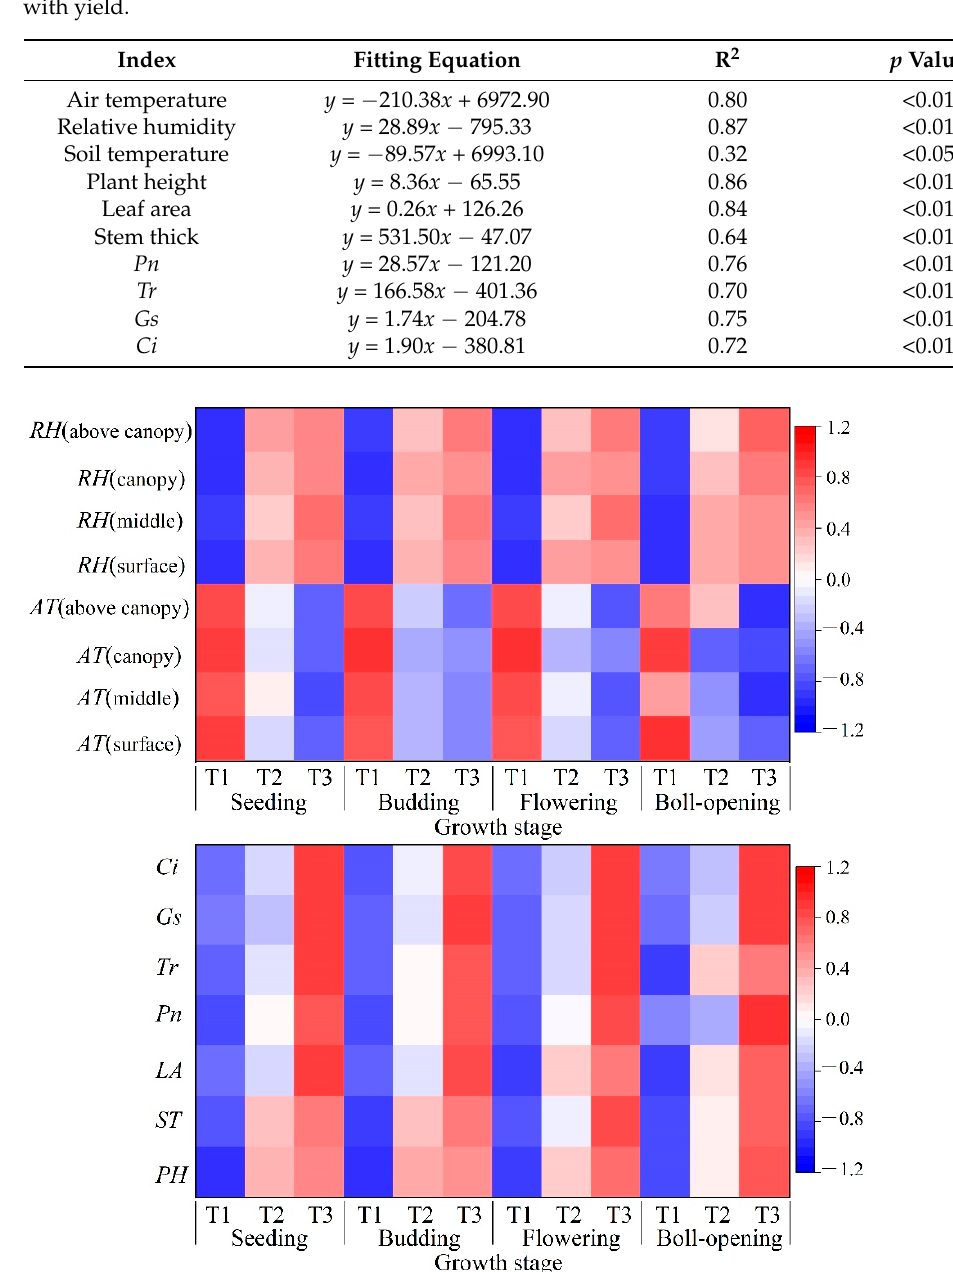
Table 6. Fitting analysis of physiological growth indices and farmland microclimate indices with yield.